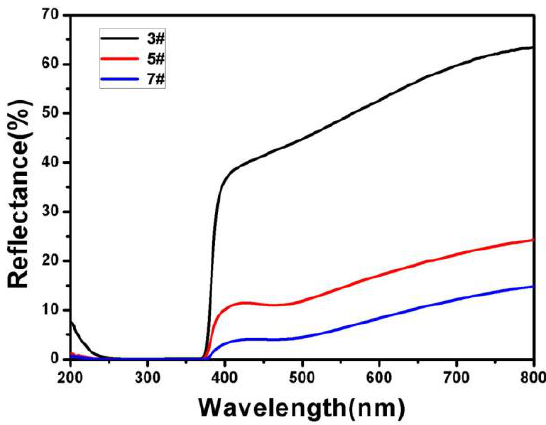
Figure 7. UV-visible reflectance of the sample: (3#) ZnO nanorods. (4#) ZnO nanorods + Ag. (7#) ZnO nanorods + Ag + Ag 3 PO 4 (deposition three times).